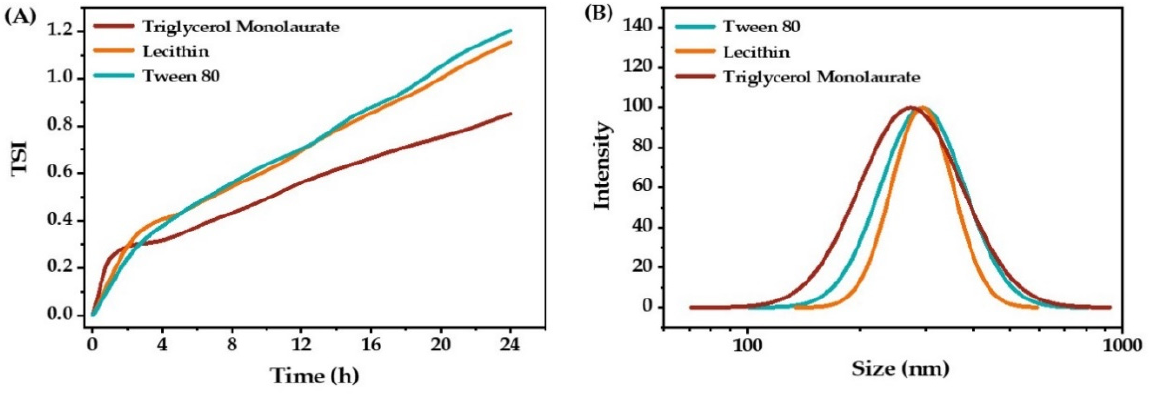
Figure 1. The stability ( A ) and droplet size distribution ( B ) of O/W emulsions stabilized by triglycerol monolaurate, lecithin, and Tween 80.